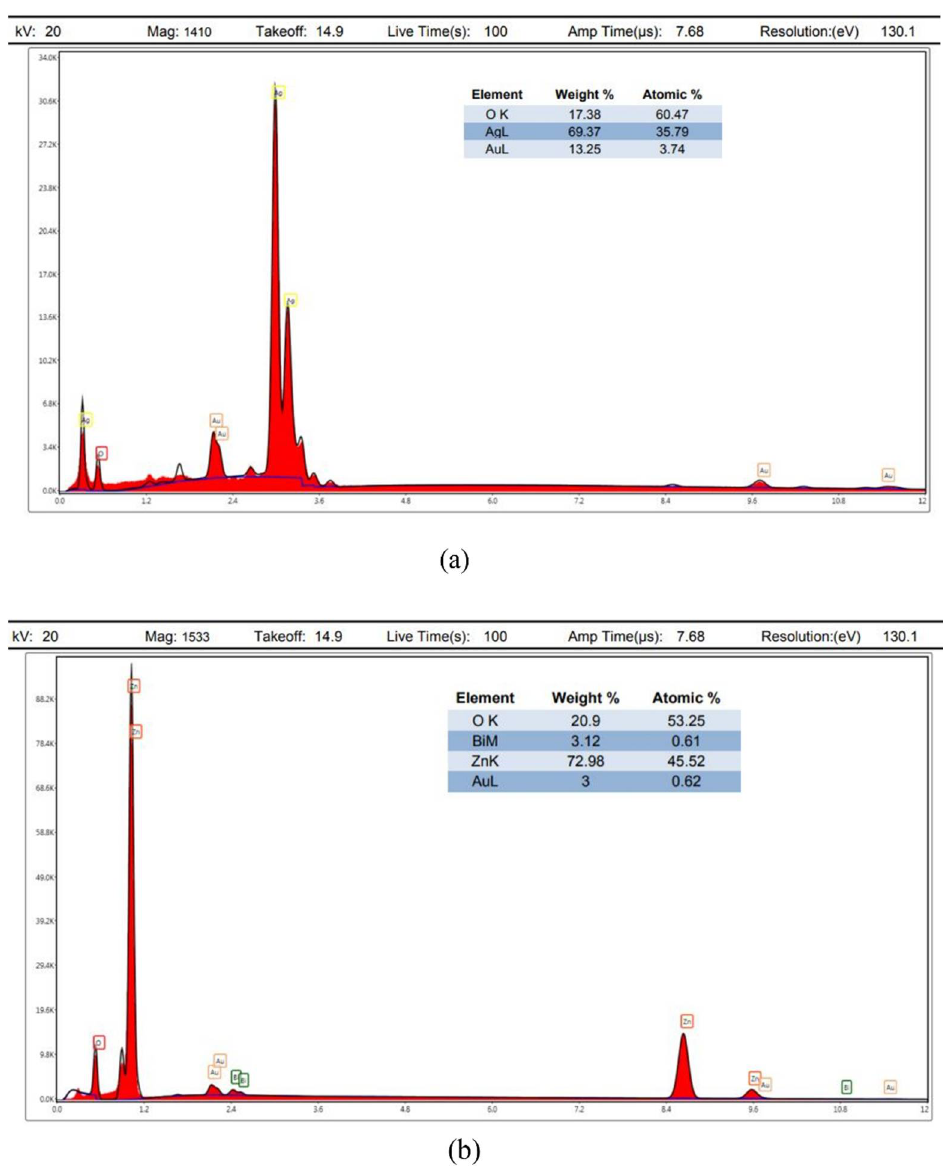
Figure 4. EDX spectrum of the ( a ) silver oxide; and ( b ) zinc electrode.